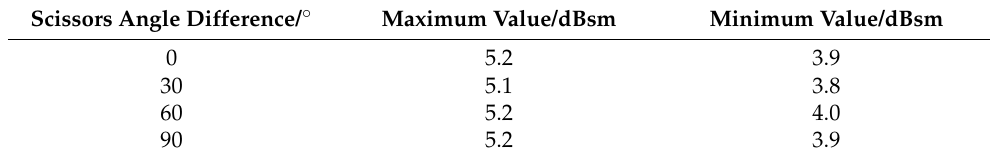
Table 13. Highest and lowest average RCS values at an azimuth angle = 180 ◦ in helicopter mode. Scissors Angle Difference/ ◦